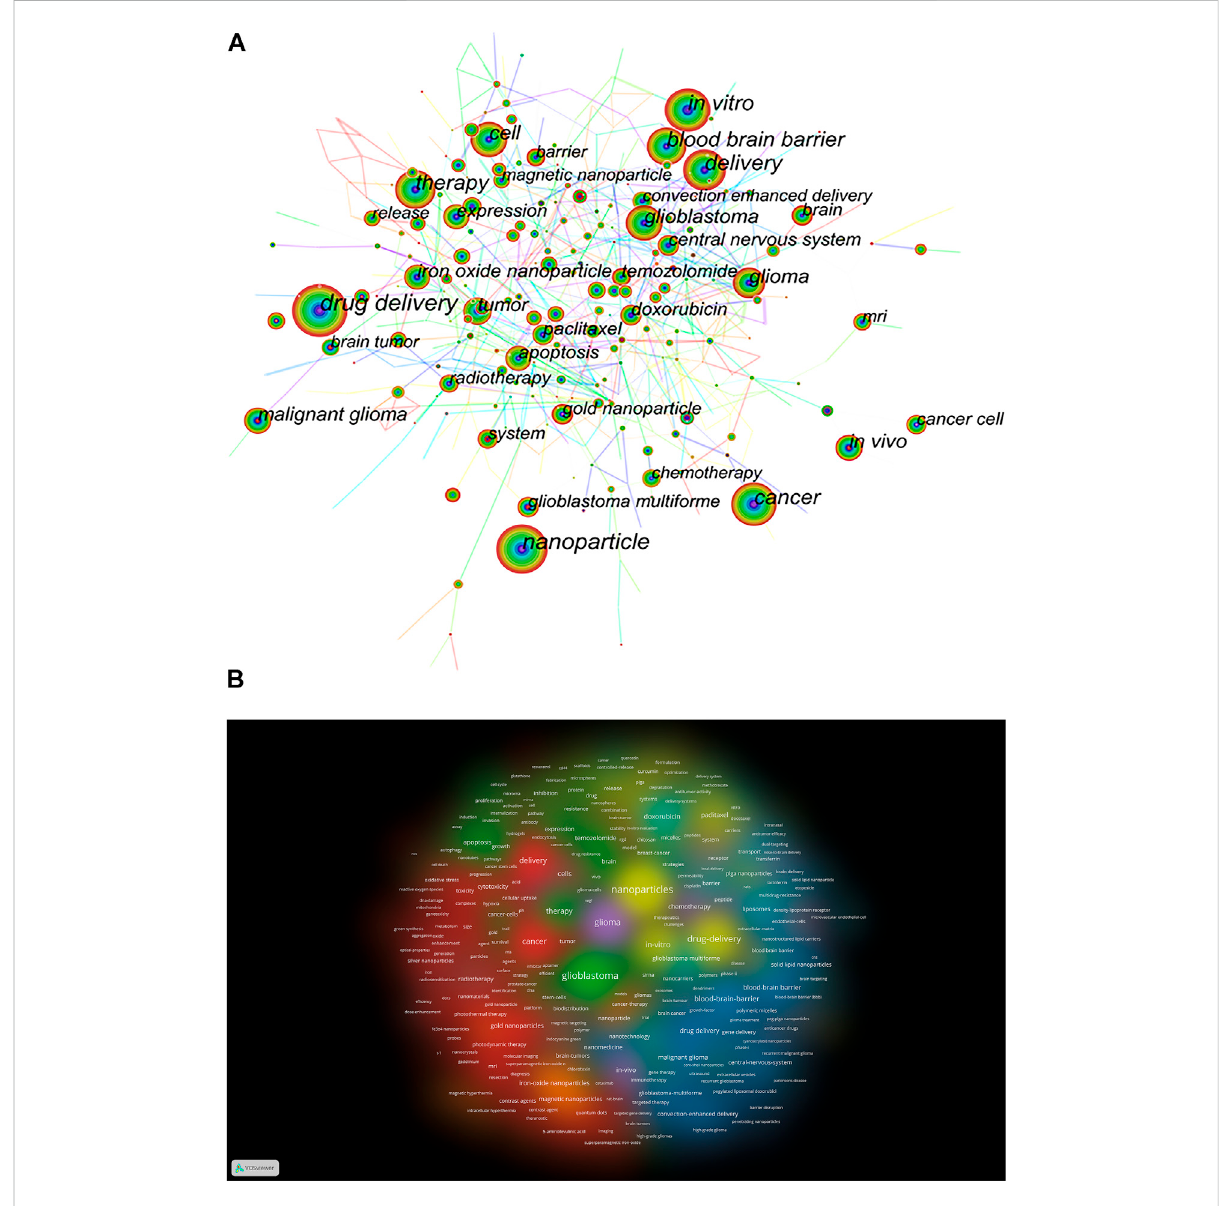
between nodes and the distance between nodes re fl ect the tightness of the keywords. The keyword burst visualization map showed the burst intensity of the top 25 keywords (Supplementary Figure S5), the blue line indicated the timeline, and the red part of the blue timeline indicated the time interval of the burst.